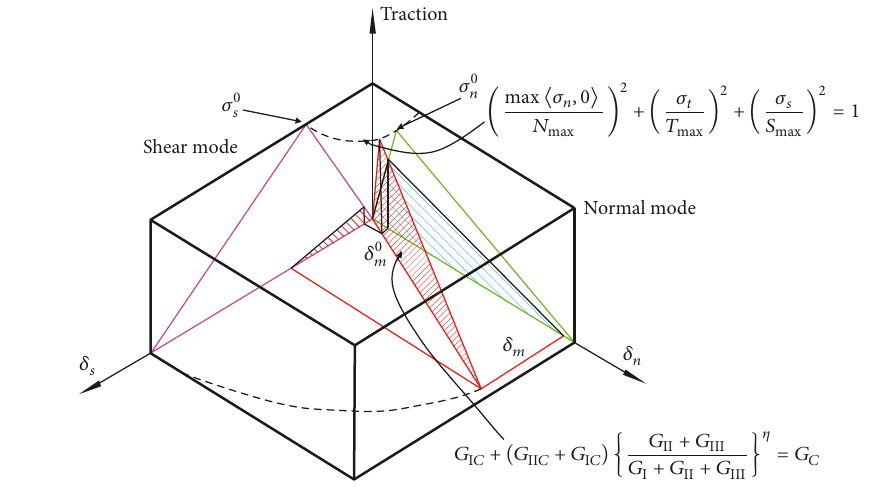
Figure 6: Mixed-mode traction-separation law.